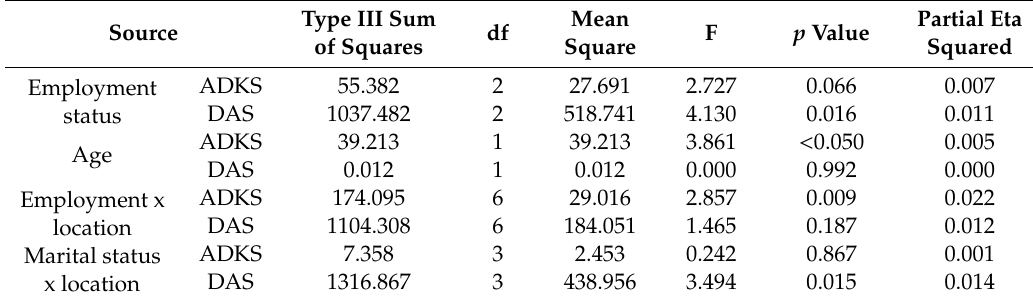
Table A2. Post-hoc test results showing the e ff ects of the demographic factors on the individual components of dementia literacy.